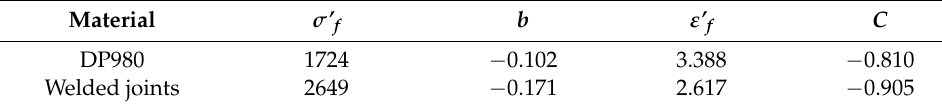
Figure 14. S - N curves of ( a ) DP980 steel sheet and ( b ) welded joints. Table 5. Fatigue properties of the DP980 steel and welded